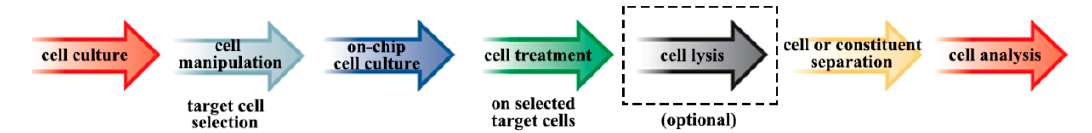
Figure 1. A collection of single-cell analysis on microfluidics from cell culture to cell analysis.